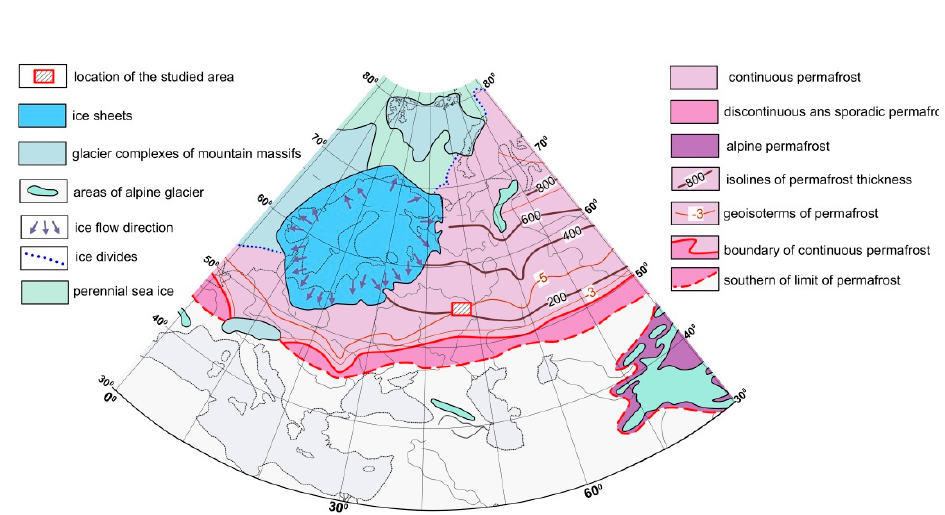
Figure 1. Glaciation and permafrost on the Eastern Europe Plain during the Last Glacial Maximum 20–18 thousand years ago ([40] with changes). Table 1. Cryogenic sediments and soils of Pre-Volga region according to the reference section in the Aleksandrovsky quarry ([61] with changes).